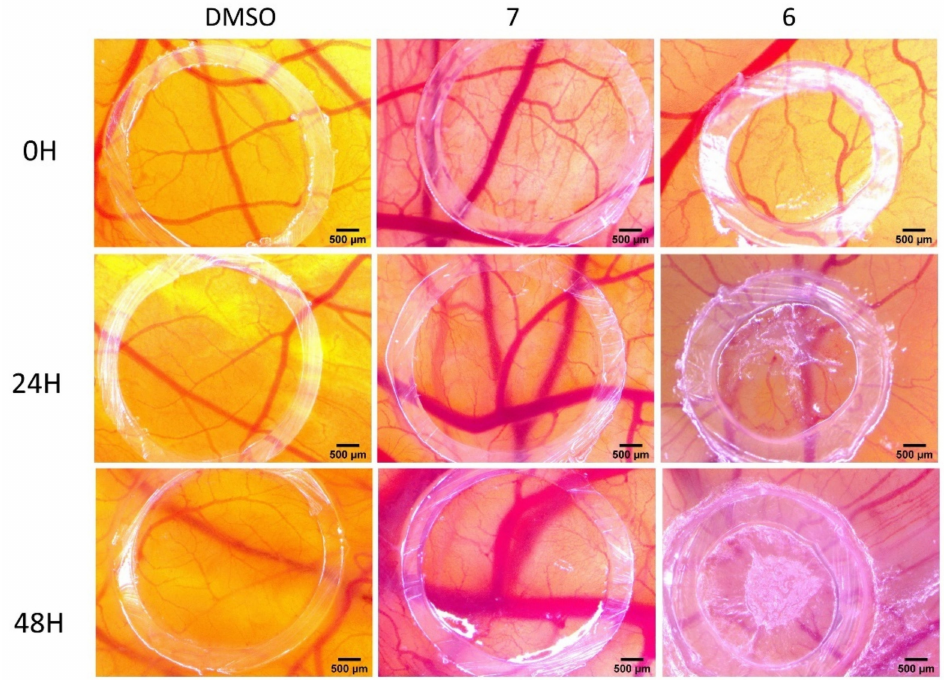
Figure 15. The angiogenesis assessment of compounds 6 and 7 using the CAM assay. Stereomicro- scope images demonstrate daily modifications upon the treated vascular plexus; scale bars represent 500 µ